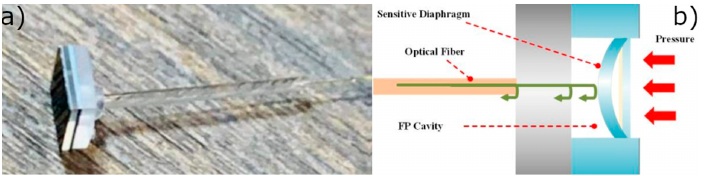
Figure 22. ( a ) Photo of pressure sensor for high temperature environment and ( b ) schematic design of its working principle [188].